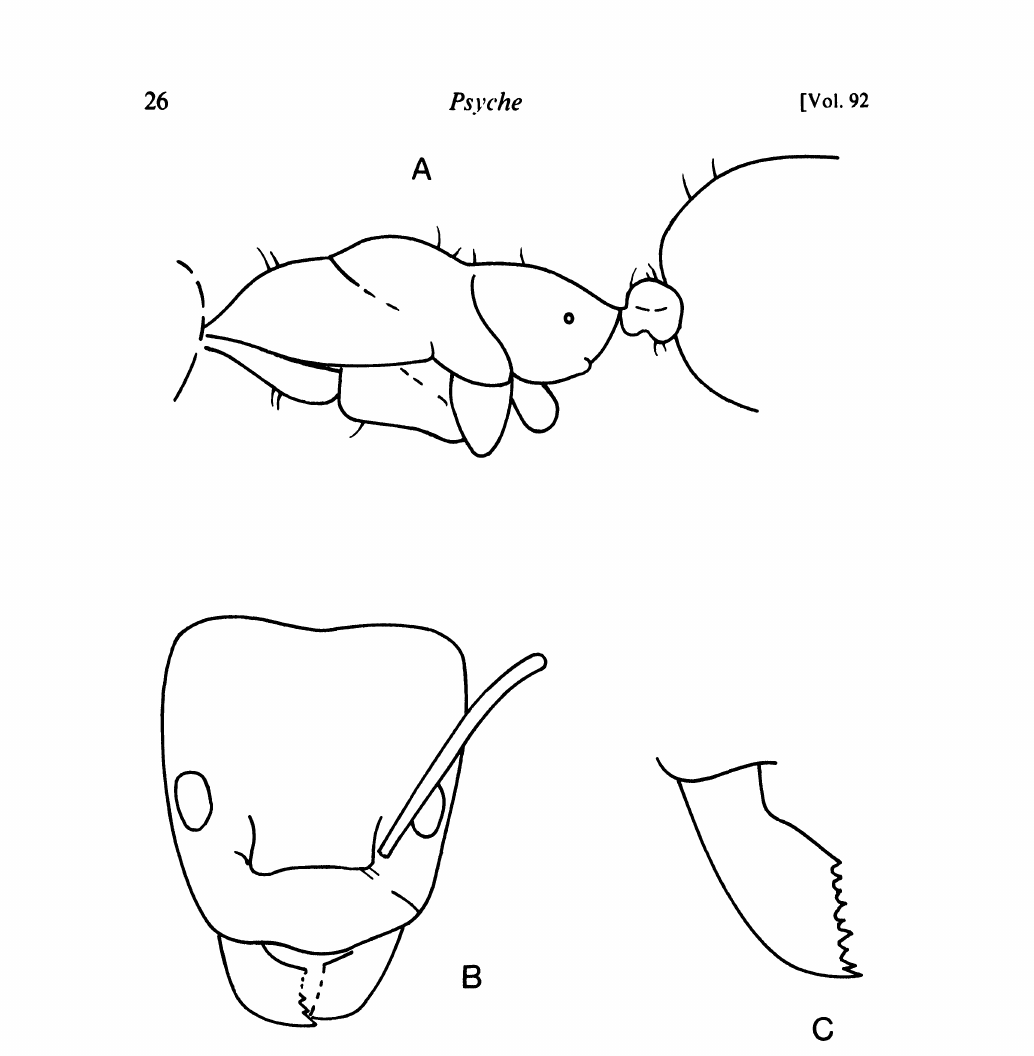
Fig. 5. Azteca alpha. A, holotype worker, side view of body; B, head of a para- type worker; C, left mandible of another paratype worker. Holoo’pe